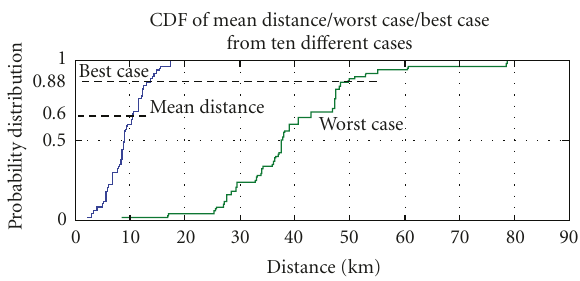
Figure 9: The CDF of mean distance/best case/worst case with di ff erent random points sets in the small step size